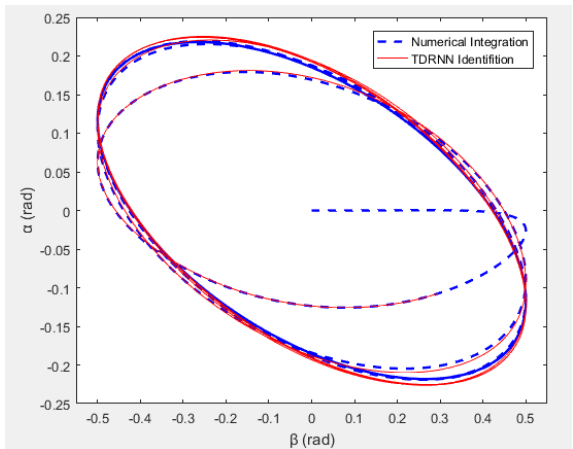
Figure 7. Input – output characteristic of the aeroelastic system with cubic-spring nonlinearity.